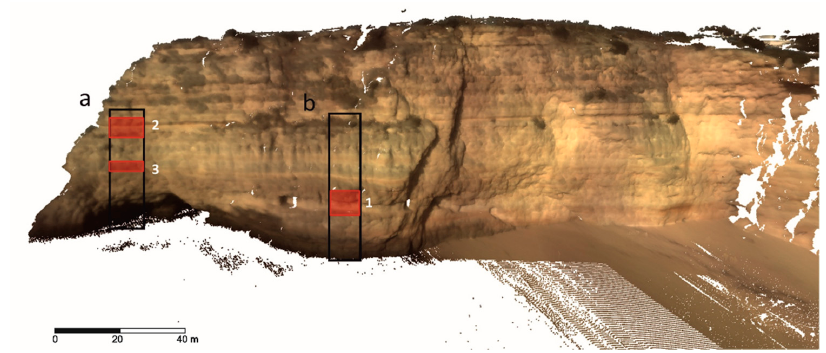
Figure 6. Real-color point cloud from a light detection and ranging (LiDAR) survey of the western cliff face. Regions a and b contain voids selected for further testing of the proposed method for surveying and classifying coastal notches. Numbers 1–3 represent approximate locations of analyzed notches.